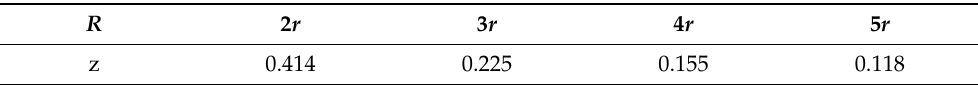
Table 1. Gravitational redshift z of a black hole at the distance R = nr from its center, where n = 2,3,4,5 and r is the Schwarzschild radius.